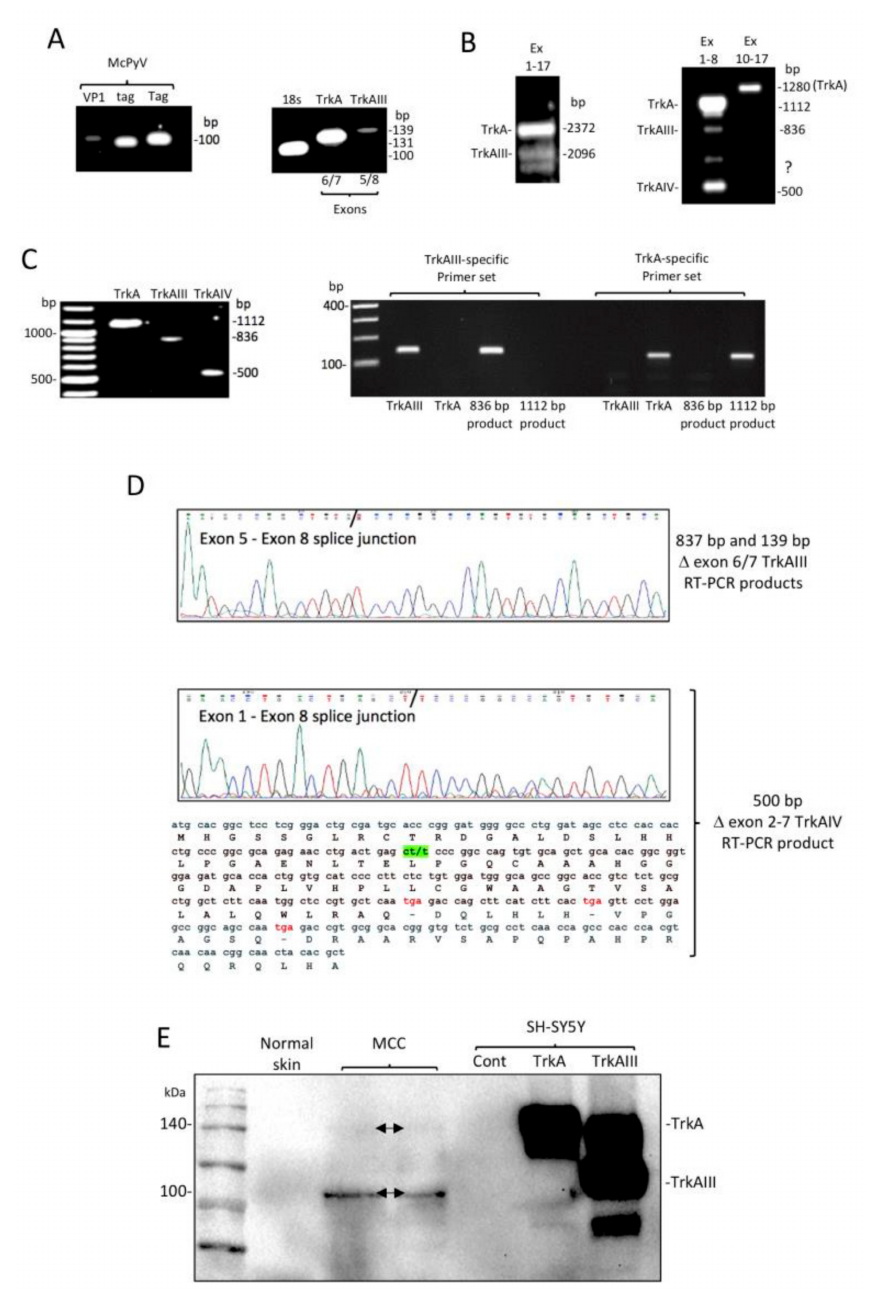
Figure 4. ( A ) RT-PCR demonstrating MCPyV VP1, small t-antigen (tag) and large T-antigen (Tag) (left panel), and 18s rRNA, exon 6 and 7 containing (exons 6 / 7 TrkA) and noncontaining (exons 5 / 8, TrkAIII) products generated from metastatic MCPyV-positive MCC RNA. ( B ) RT-PCR demonstrating (left panel) a 2372-bp product expected for full-length fully spliced TrkA and a 2096-bp product expected for ∆ exon 6–7 TrkAIII generated from metastatic MCC RNA using primers spanning TrkA exons 1 to 17, and (right panel) a 1112-bp product expected for fully spliced TrkA exons 1–8, an 836-bp product expected from ∆ exon 6–7 TrkAIII exons 1–8, a yet to be characterised product (?) and the 500-bp product characterised as ∆ exon 2-7 TrkAIV, generated from metastatic MCPyV-positive MCC RNA, using primers spanning TrkA exons 1 to 8, plus a unique 1280-bp product expected for fully spliced TrkA exons 10–17, generated from metastatic MCPyV-positive MCC RNA using primers spanning TrkA exons 10 to 17. ( C ) Gel-purified 1112-bp (fully spliced TrkA), 836-bp ( ∆ exon 6–7 TrkAIII) and 500-bp ( ∆ exon 2-7 TrkAIV) TrkA exon 1 to 8 RT-PCR products (left panel), and (right panel) RT-PCR